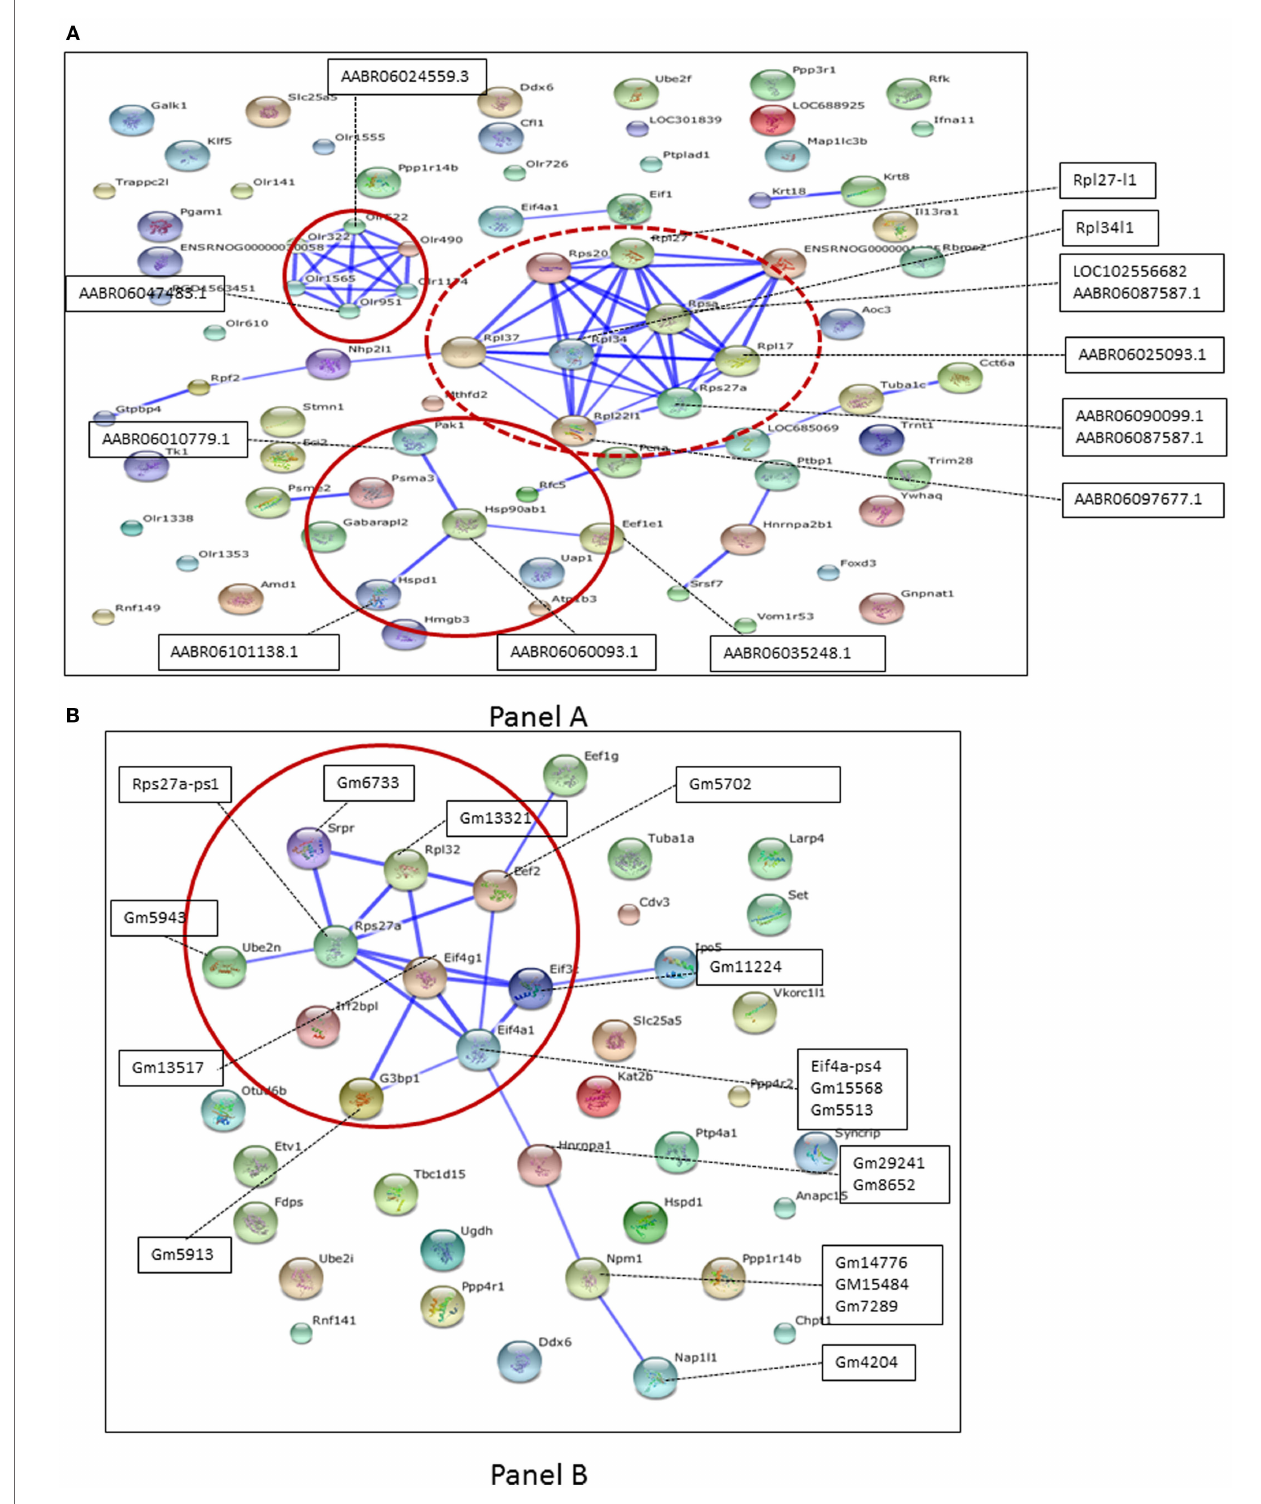
FigUre 3 | (a) Protein–protein interactions for pseudogene targets (black box) obtained using rat reference at confidence level 0.7. Red circle are the networks studied. Dotted lines indicate association between pseudogene and parental genes (the former appear superimposed, being not annotated in STRING). (B) Protein–protein interactions for pseudogene targets (black boxes) obtained using mouse reference at confidence level 0.7. Red circle are the networks studied. Dotted lines indicate association between pseudogene and parental genes (the former appear superimposed, being not annotated in